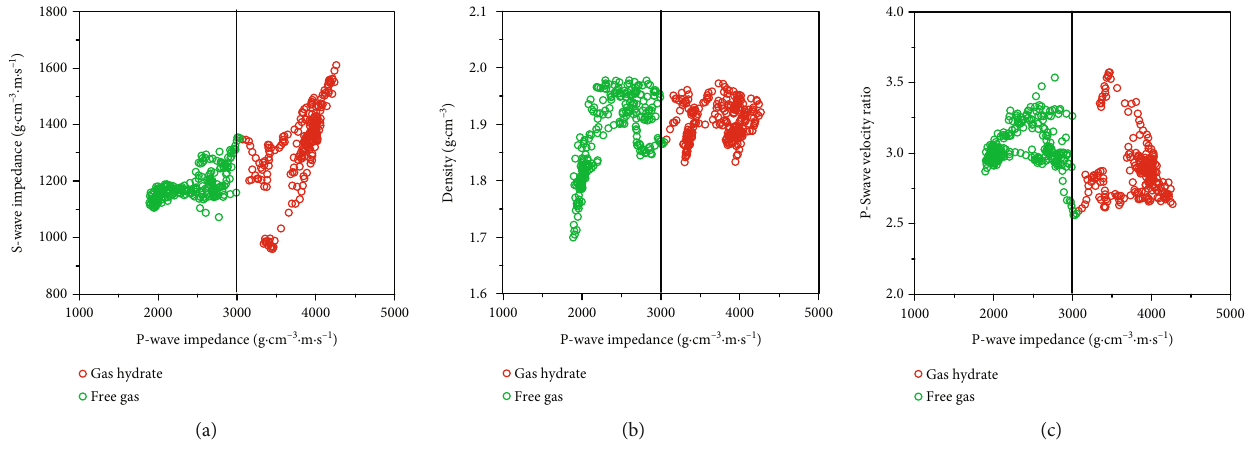
Figure 3: Intersection plate of di ff erent elastic